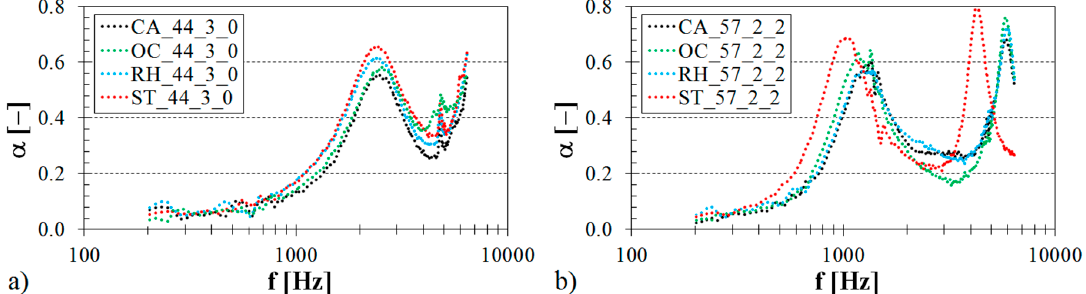
Figure 3. Influence of the pore geometry of the 3D-printed ABS material on the frequency dependencies of the sound absorption coefficient: ( a ) volume ratio V r = 44%, sample thickness t = 3 cm, air space size a = 0 cm, ( b ) volume ratio V r = 57%, sample thickness t = 2 cm, air space size a = 2 cm.